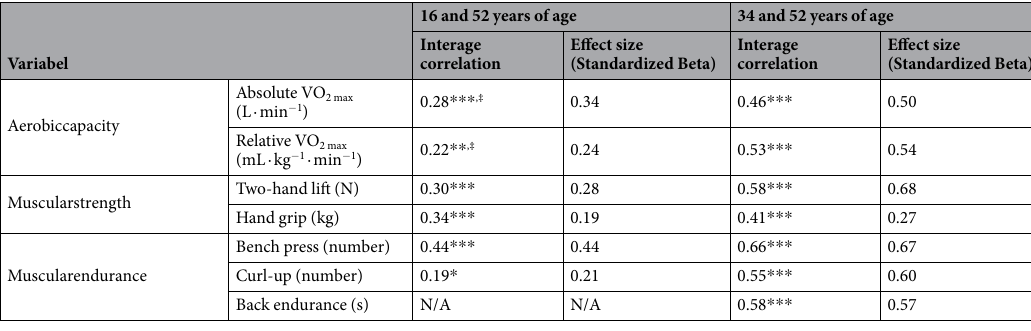
Table 2. Interage correlations and effect sizes for physical capacity between 16 and 52 years of age and between 34 and 52 years of age. * p < 0,05, ** p < 0,01, *** p < 0,001, N/A = not applicable because the test was not performed at 16 years of age. ‡ The value at 16 years of age is estimated from the nine minute run. Gender and height 2 at 52 years of age are included in all analyses except for the analyses of aerobic capacity (see Methods, Statistical